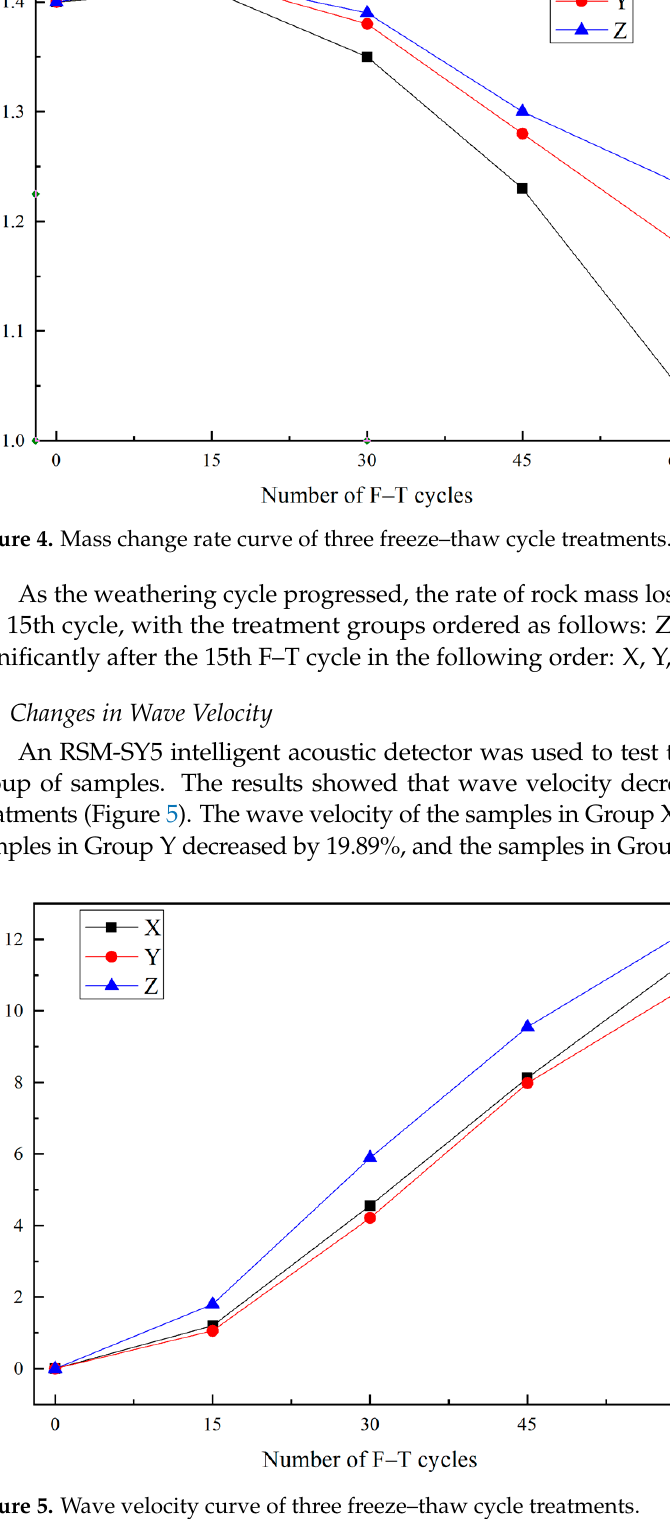
( b ) Figure 3. Samples. ( a ) Results of thin section identification test. (Pl: Plagioclase, Q: Quartz, Si: sili- ceous). ( b ) Samples for melting snow treatment. Each set of test samples was divided into 5 groups of 5 samples each, which were subjected to 0, 15, 30, 45, and 60 F–T cycles, respectively. The mass loss rate and wave propagation velocity of the sample were recorded, and uniaxial compression experiments were carried out to study the mechanisms of mechanical change. In addition, X-ray dif- fraction (XRD) and scanning electron microscopy (SEM) analyses were performed to in- vestigate the weathering mechanisms, mineral changes and micromorphology in the sam- ples subjected to snowmelt and rainfall infiltration. 4. Results 4.1. Changes in Mass The mass test of the samples was based on the test methods of rock for highway en- gineering (JTG E41-2005, China) specifications. The samples subjected to the snow melting and rainfall infiltration showed more significant changes in mass (Figure 4). The mass loss rate of samples was determined using the formula given in JTG E41-2005 Part 5 (Test methods of rock for highway engineering, 2005) as follows: